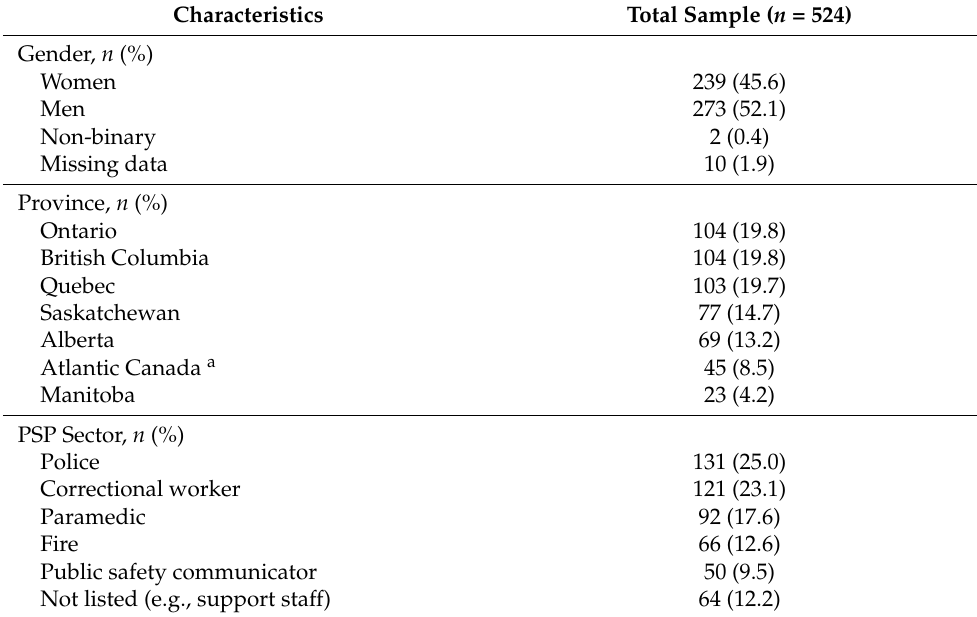
Table 1. Participant